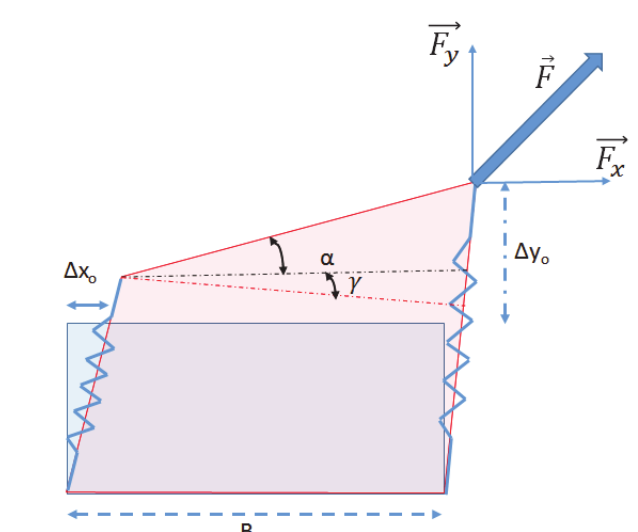
Fig. 12: Joint modelled using two springs, a force being externally applied to a free rotation point located at the upper right corner of the